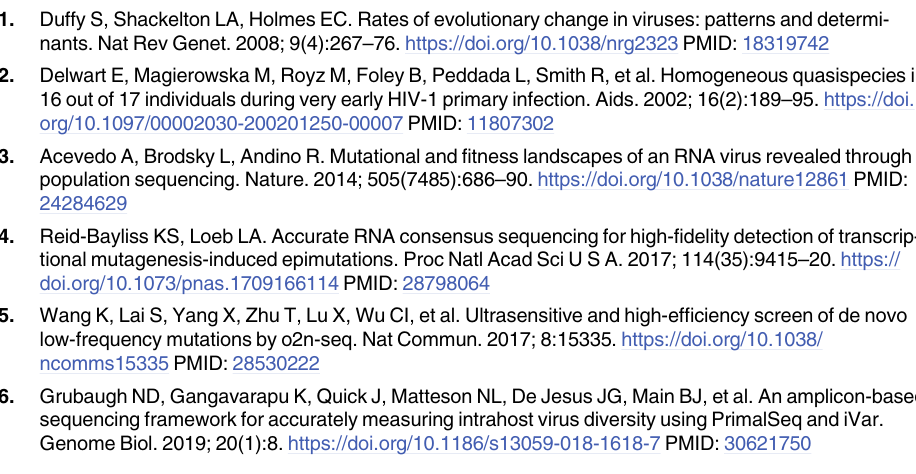
S8 Fig. Technical replicates of AccuNGS sequencing. Technical replicates of HIV9 sample, all sequenced with AccuNGS. The two left panels were performed using Primer IDs (pIDs) whereas the right panel represents no primer ID. All three replicates show an excess of G > A mutations. While variants frequencies differed between samples, π diversity estimates were consistent (see S1D Fig), and multiple haplotypes bearing many G > A mutations were inferred in all three replicates. The highest coverage was obtained for the left panel (~320,000), followed by the middle panel (~270,000) and lastly by the right panel (~100,000). Higher coverage and a larger number of genomes sequenced on the left panel are likely responsible for lower fre- quency errors, in line with S2 Fig.